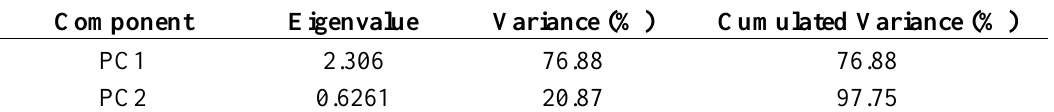
Table 5. Variances (eigenvalues) obtained for the first two principal components.